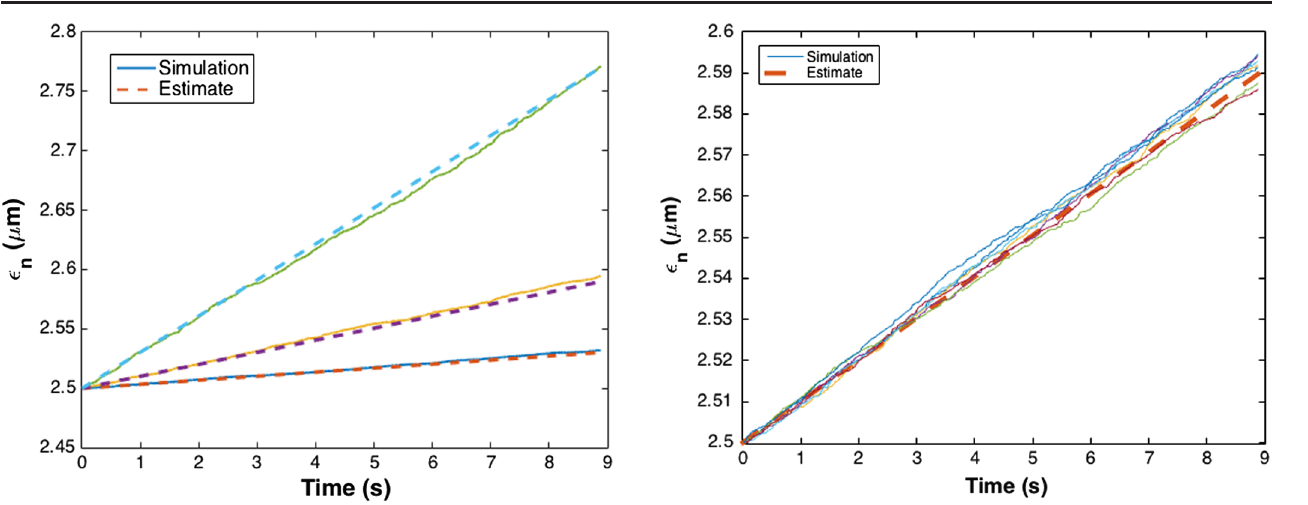
FIG. 13. Simulation results with different phase noise PSD (solid lines). Theoretically estimated trend line (dashed lines).